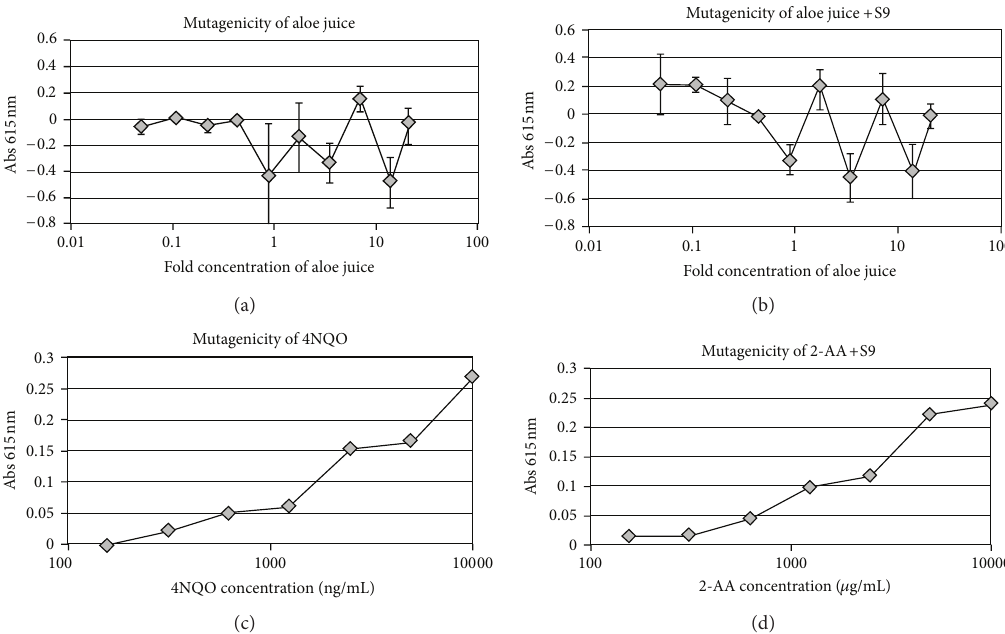
Figure 1: Effects of DCWL aloe vera juice on DNA damage repair. Absorbance reflects measurement of SOS transgene ( 𝛽 -galactosidase) induction and subsequent substrate conversion. Symbols represent means of triplicate wells incubated in the absence or presence of S9 rat liver extract. Error bars represent standard